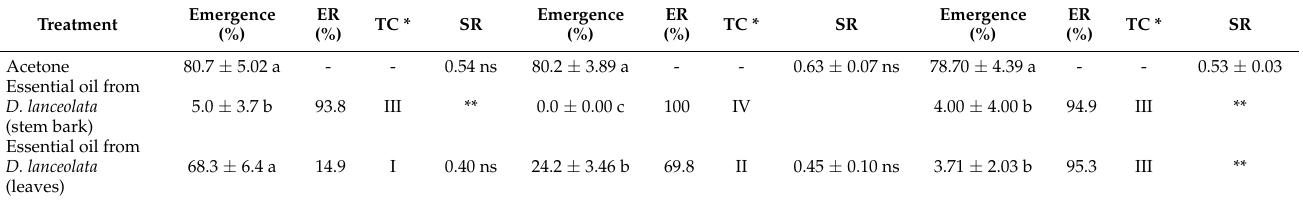
Table 4. Emergence (%), emergence reduction (ER), toxicological class (TC), and sex ratio (SR) for Trichogramma pretiosum adults treated with essential oils from the stem barks and leaves of Duguetia lanceolata in the egg-larvae, pre-pupal and pupal stages inside the eggs of Ephestia kuehniella .